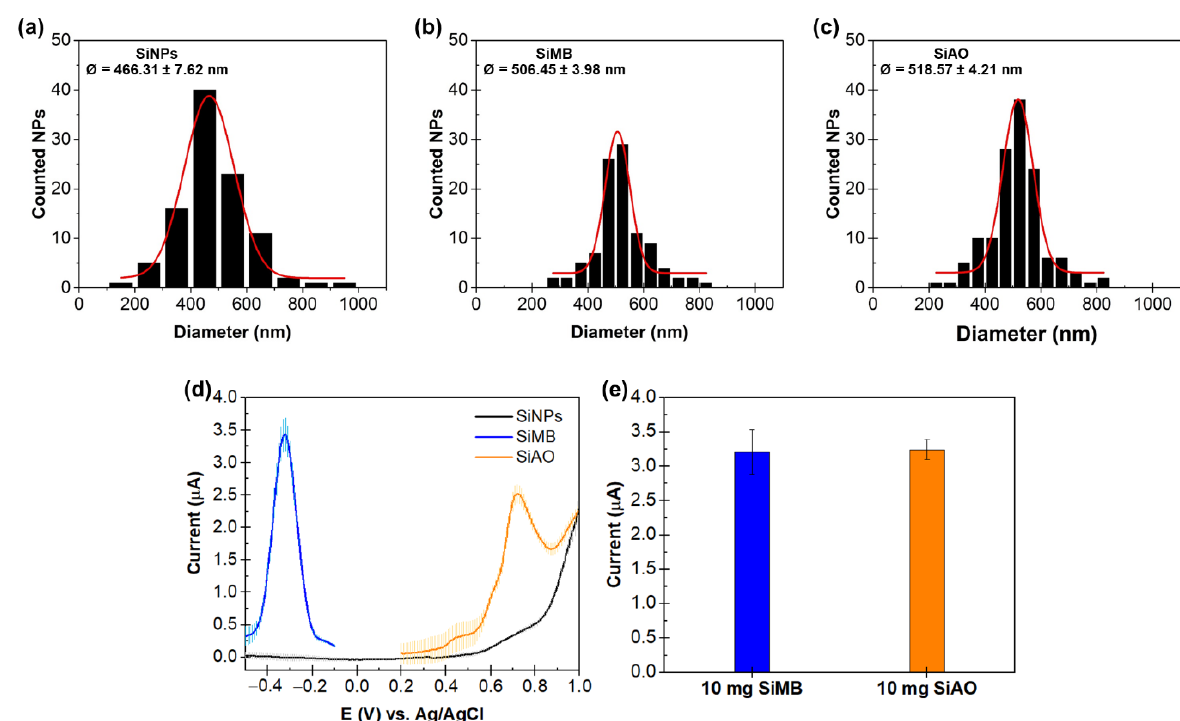
Figure 1. Characterization of the silica nanoparticles and Si-dye. Size distribution of ( a ) SiNPs, ( b ) SiMB, and ( c ) SiAO. The nanoparticles were synthesized using a modified Stöber method. Both dye-doped SiNPs (Si-MB and Si-AO) diameter sizes increased − 10% compared to the unmodified SiNPs. ( d ) Differential pulse voltammogram showing the peak potentials of SiNPs coated with a redox – dye layer (black line = SiNPs, blue line = SiMB and orange line = SiAO). The peak currents could be observed at -0.3 V (SiMB) and 0.7 V (SiAO) while no peak current was observed with unmodified SiNPs. ( e ) Current responses of SiMB (blue bar graph) and SiAO (orange bar graph) showed similar results at 10 mg/mL concentration. The current signals presented as mean values ± standard deviation (SD) from the electrochemical measurements ( n = 5).